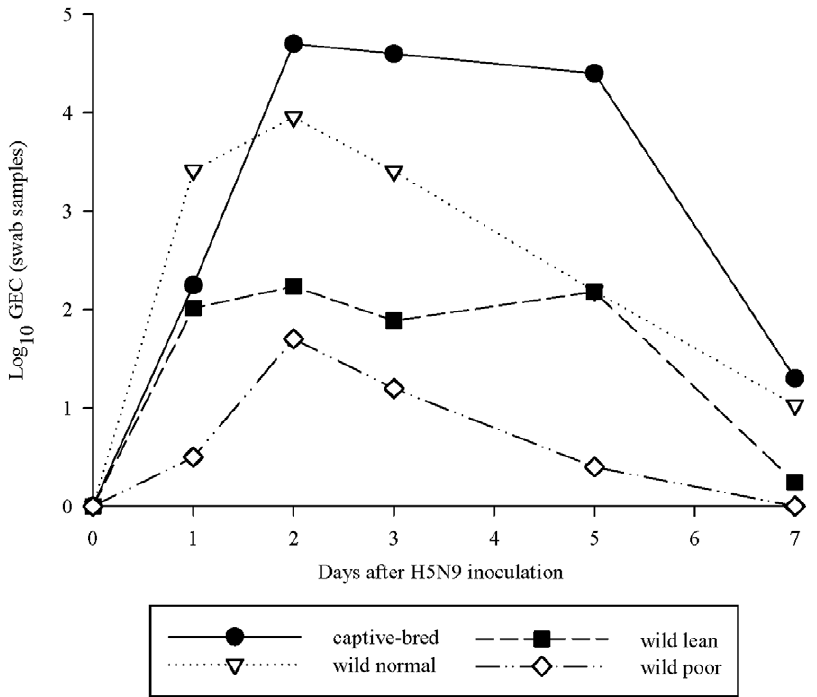
Figure 3. Average viral shedding for captive-bred and wild mallard treatment groups. Data points represent mean genome load (log 10 GEC/140 m l of swab sample fluid) for each day sampled.